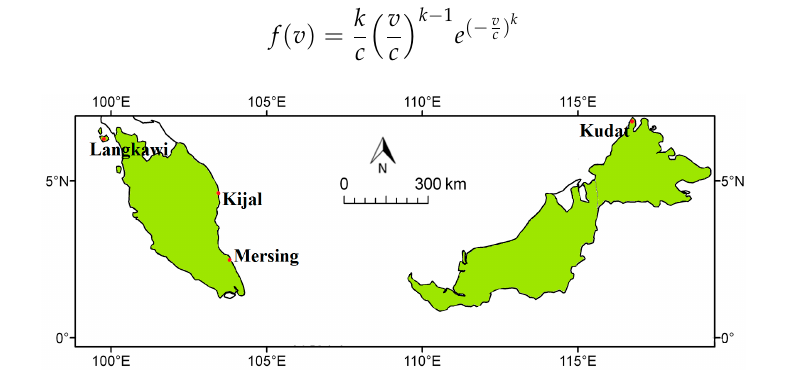
Figure 1. Map showing the selected sites.